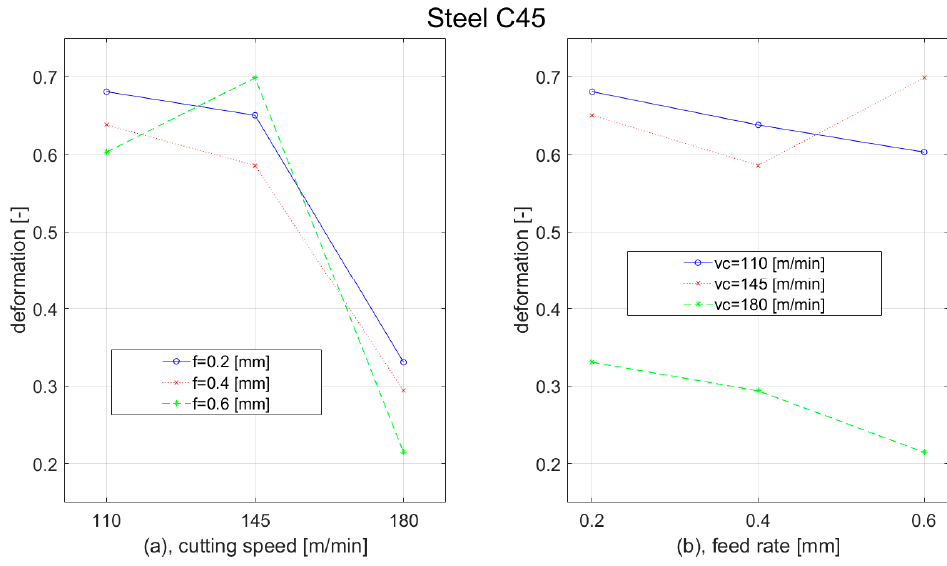
Figure 10. Graph of deformation dependence of Steel C45 on: ( a ) cutting speed; ( b ) feed rate.